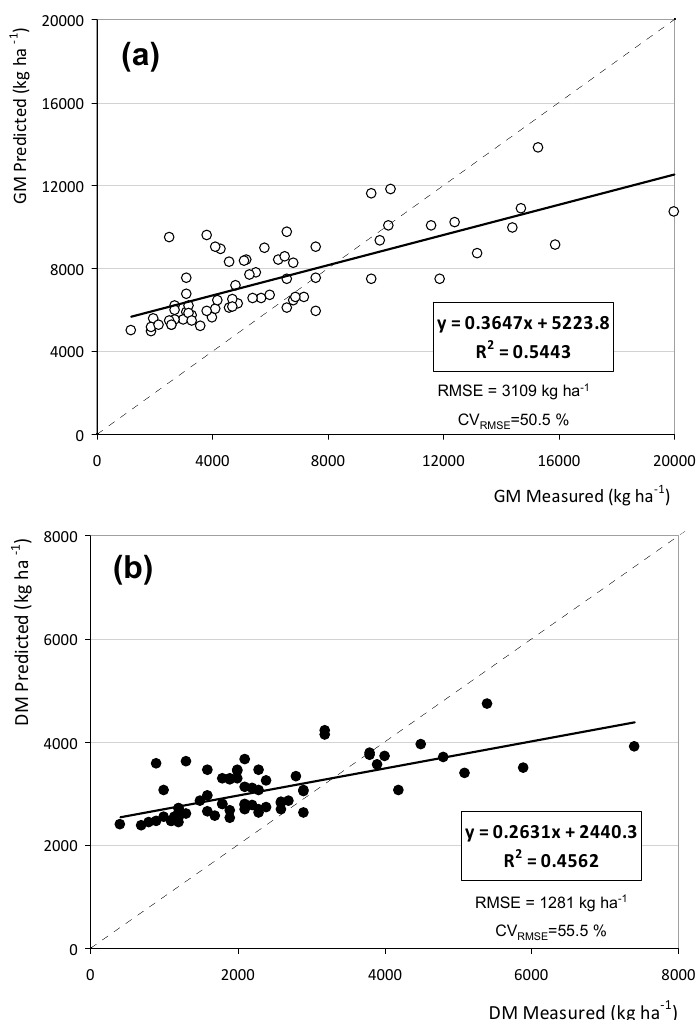
Figure 10. Relation between pasture productivity measured (( a ) green matter; ( b ) dry matter (DM)) in 2019, in eight experimental fields (“Azinhal”, ”Cubillos”, “Grous”, “Mitra B”, “Murteiras”, “Padres”, “Quinta França” and “Tapada”—validation phase), and pasture productivity predicted based on the equations obtained in calibration phase for pasture moisture content (PMC) < 70%. R 2 —coefficient of determination; RMSE—root mean squared error; CV RMSE —coefficient of variation of root mean squared error.